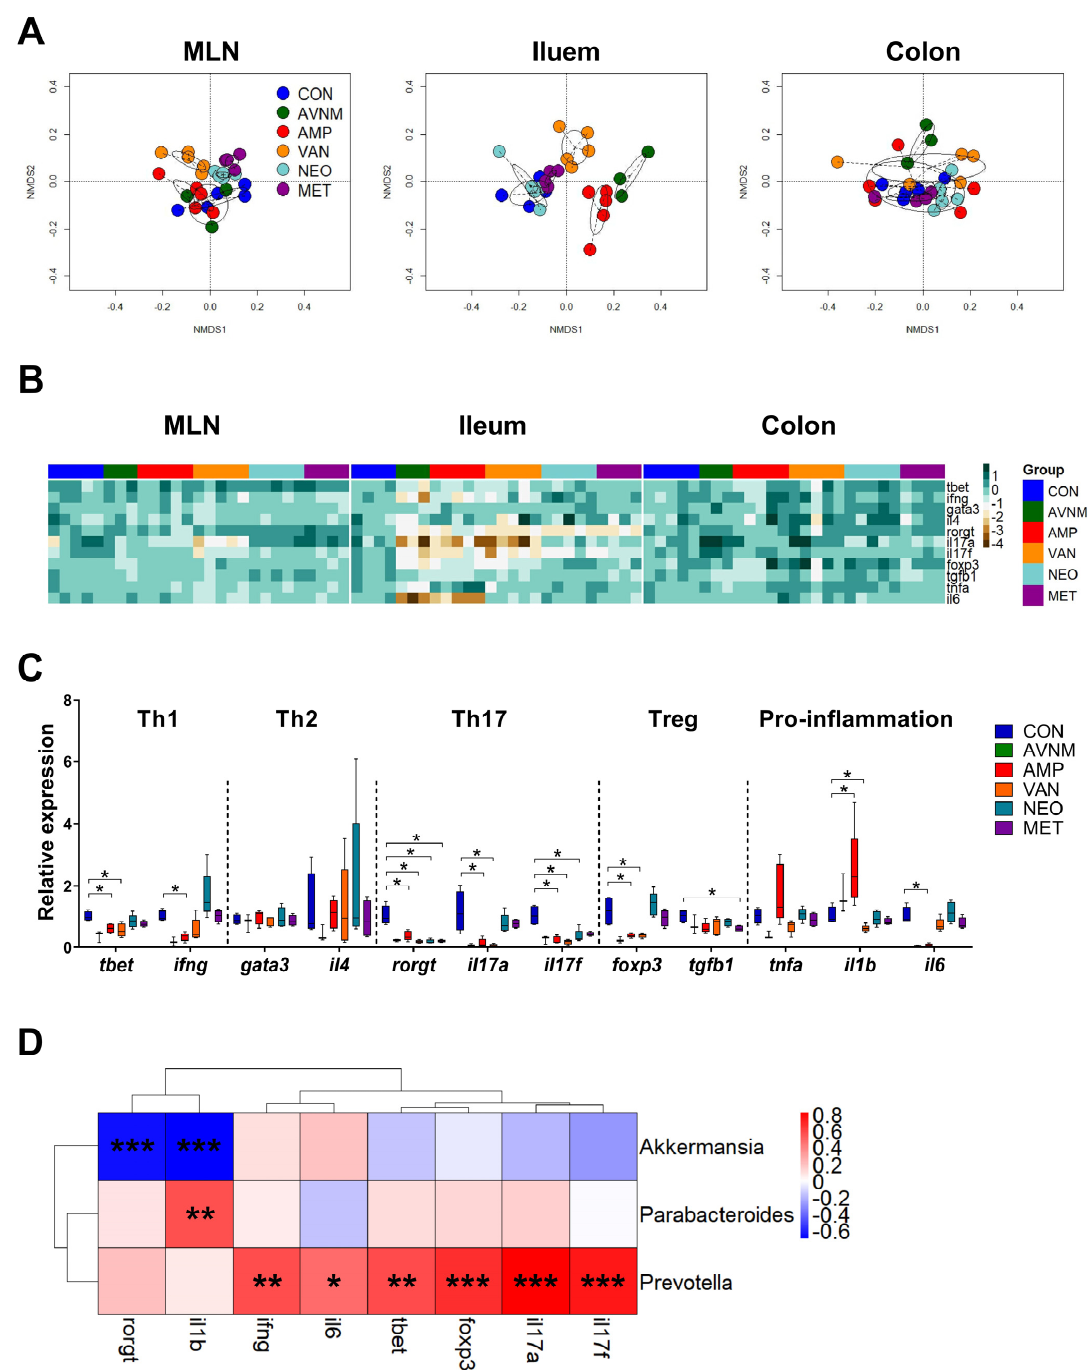
Figure 4. Effects of antibiotic treatment on immune-related gene expression in the gut and cor- relation with the gut microbiota. ( A ) NMDS plots of the fold expression of gene expression in MLN, ileum and colon with Bray–Curtis distance. ( B ) Heatmap of -log of the fold expression in MLN, ileum and colon. ( C ) The relative expression of genes related to Th1, Th2, Th17, Treg, and pro-inflammation in ileum. ( D ) The Spearman’s correlation analysis between relative abun- dance of major discriminative taxa and the relative expression of genes significantly changed to CON in AMP and VAN groups. Data are expressed as the mean ± SEM. Asterisks indicate a statistically significant difference (* p < 0.05, ** p < 0.01, *** p < 0.001; Mann–Whitney U test and Spearman’s correlation, CON, control; AVNM, mixture of ampicillin, vancomycin, neomycin and metronidazole; AMP, ampicillin; VAN, vancomycin; MET,